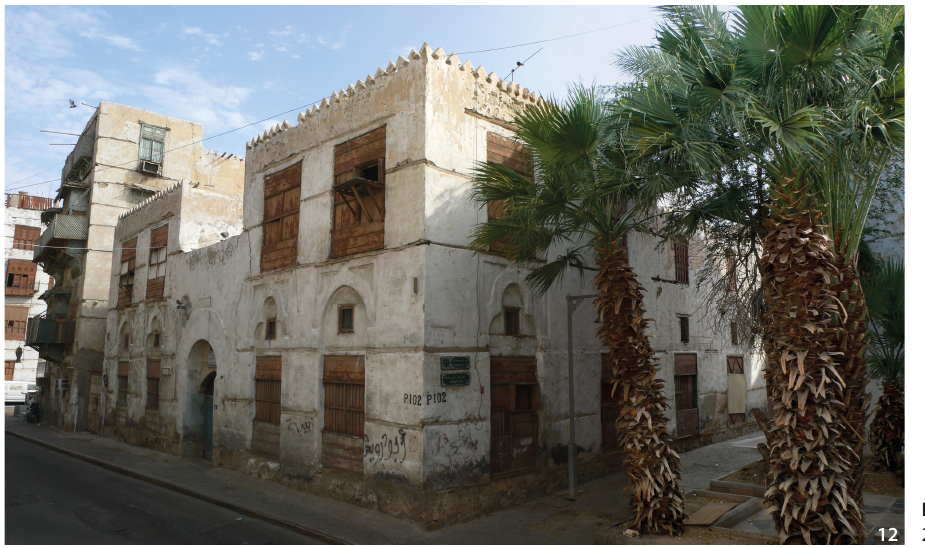
Figure 12 Historic caravanserai, 2009 (Source: F. Cristofoli).